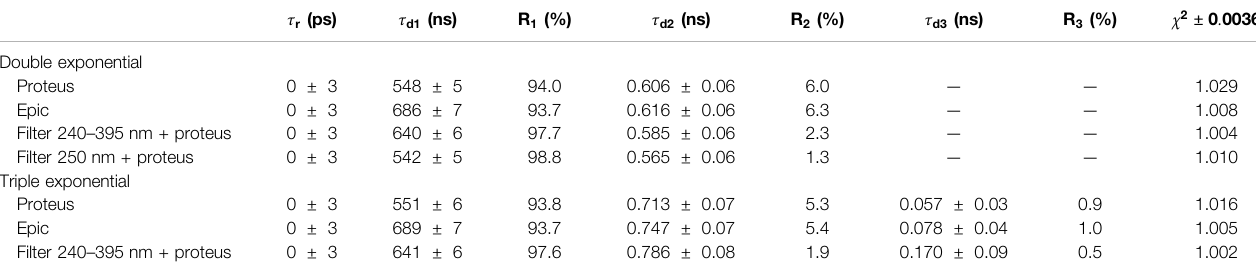
TABLE3| Parametersofthedoubleandtripleexponentialused,convolved withtheIRF,to fi tthedatafromtheTCSPCmeasurementswitha2 × 2 × 3mm 3 Ba F 2 pixelfrom Proteus and Epic. Here τ r is the rise-time, τ dn the decay times, and R n (n (cid:3) 1, 2, 3) their corresponding abundances. τ τ r (ps) d1 (ns) R 1 (%) Double exponential Proteus